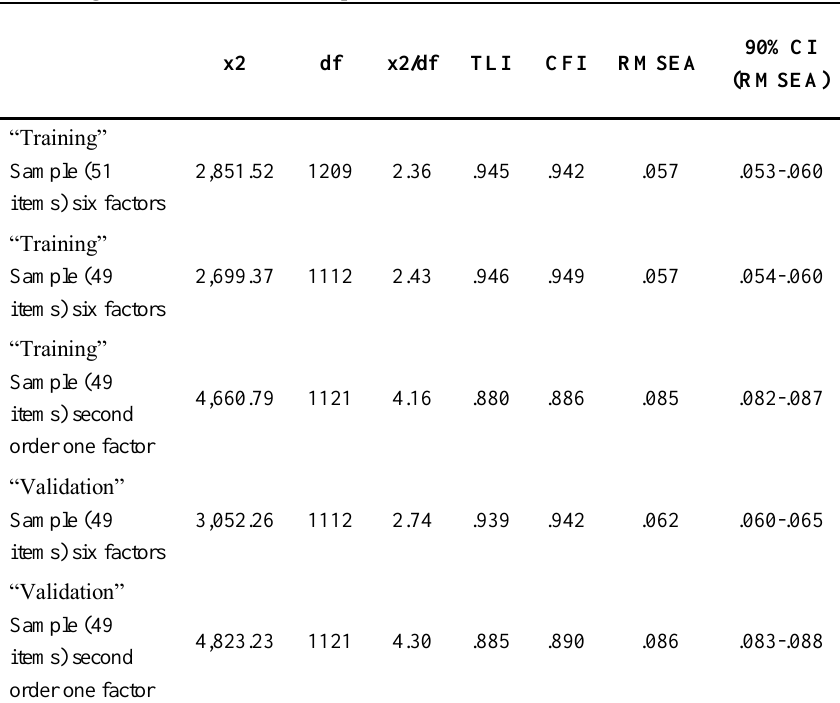
Fit Indices of the STARS' item, six-factor model, and second-order factor of “training” and “validation”